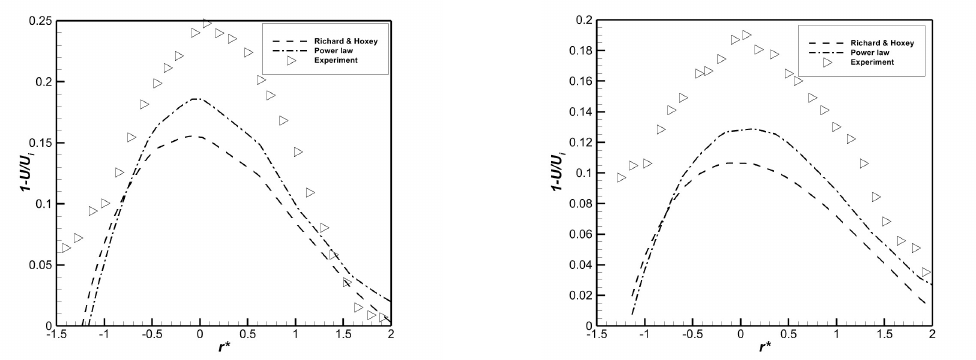
Figure 7. Power law and logarithmic velocity deficit profile in the far wake at 10 D ( left ) 15 D ( right